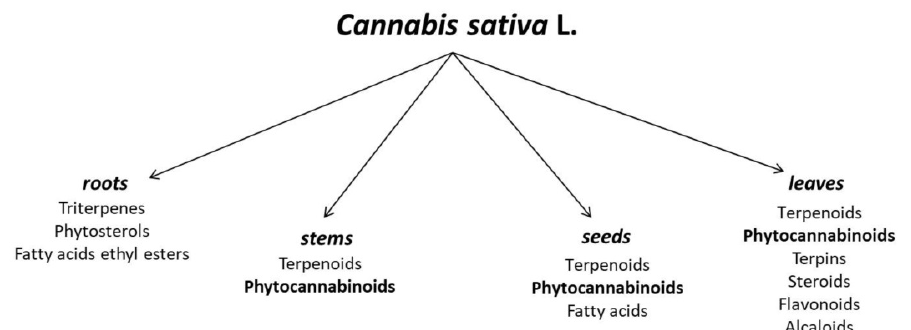
Figure 1. Chemical composition of different parts of Cannabis sativa L . [17,18].